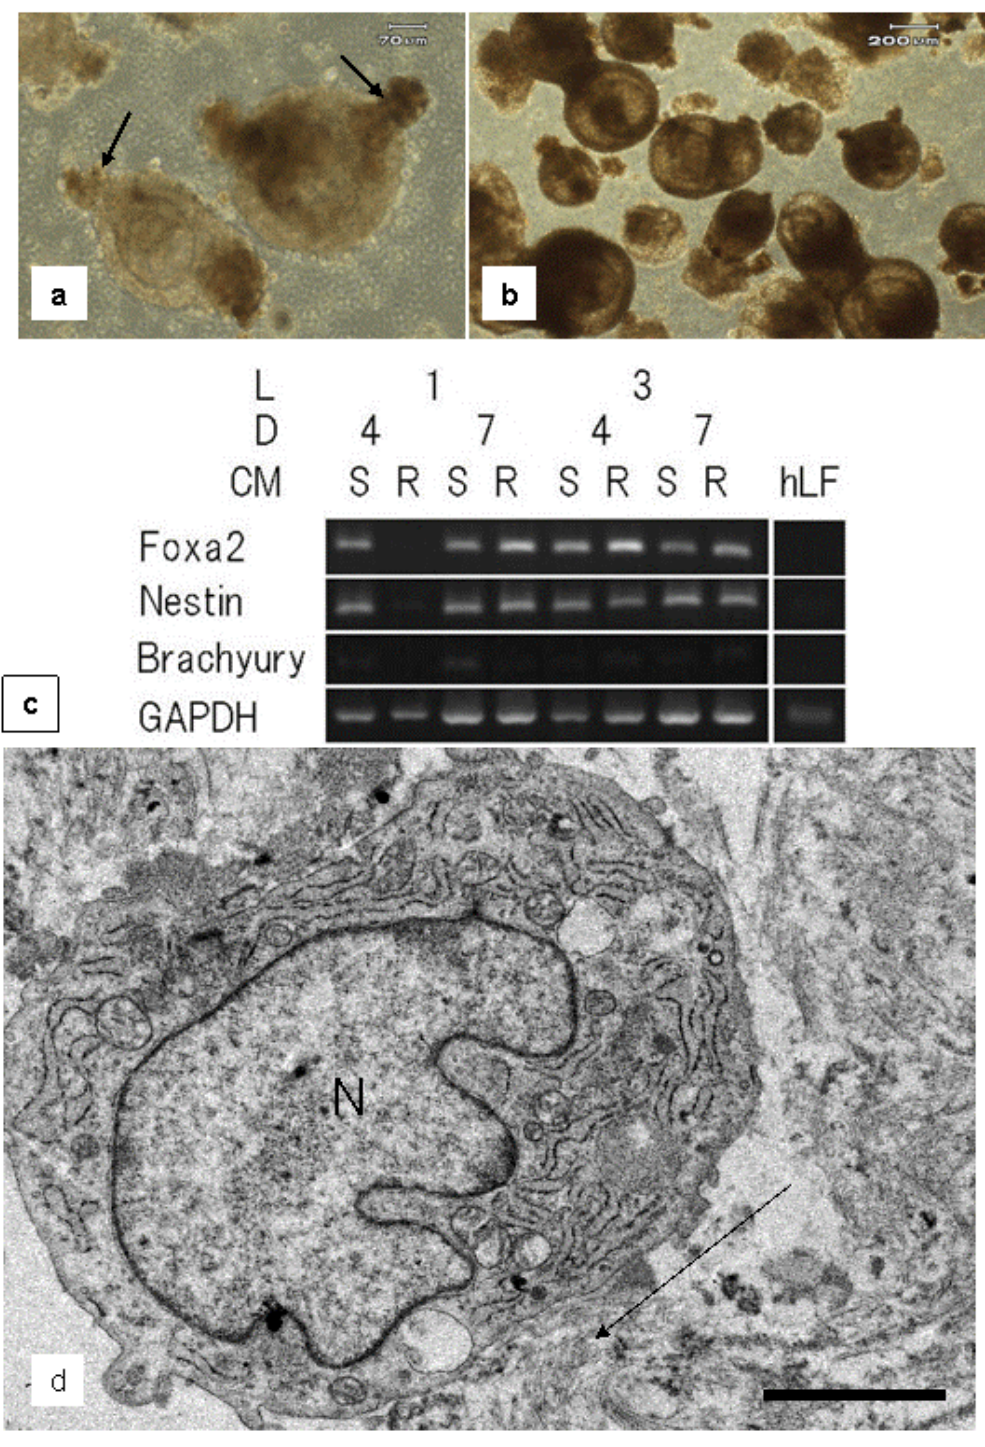
FIGURE 2. (a) EB formation on day 7 (KhES 1). Each EB has a central coelom. Small cell condensations formed on the periphery like buds (arrows). (b) EB on day 7 (KhES 3). Many EBs contained double coeloms. (c) Three germ-layer markers are detected in all EBs, although brachyury is weak under the same conditions as the other markers. L: cell line, D: culturing days, CM: culture method, S: 3SC, R: RSC, hLF: control. (d) Ultrastructural features of the mesodermal- originating cells in a KhES 1–derived EB on day 7. A round cell contains rich rER and ECM with microfibrils (arrow) and does not conjugate with other cells. N: nucleus. Bar = 2 µ